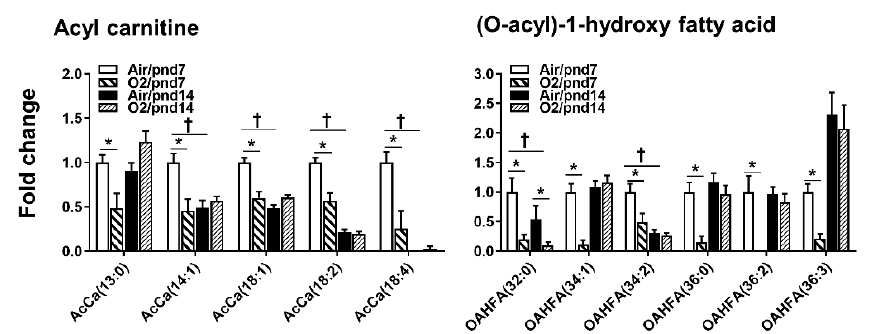
Figure 9. Compositional changes of lung AcCa and OAHFA species in mice exposed to hyperoxia as neonates. AcCa and OAHFA species in mouse lungs with 2-fold change and p < 0.05 between air and hyperoxia groups at pnd7 and pnd14 were listed. n = 6. * p < 0.05 vs. corresponding air; † p < 0.05 vs. air/pnd7 .